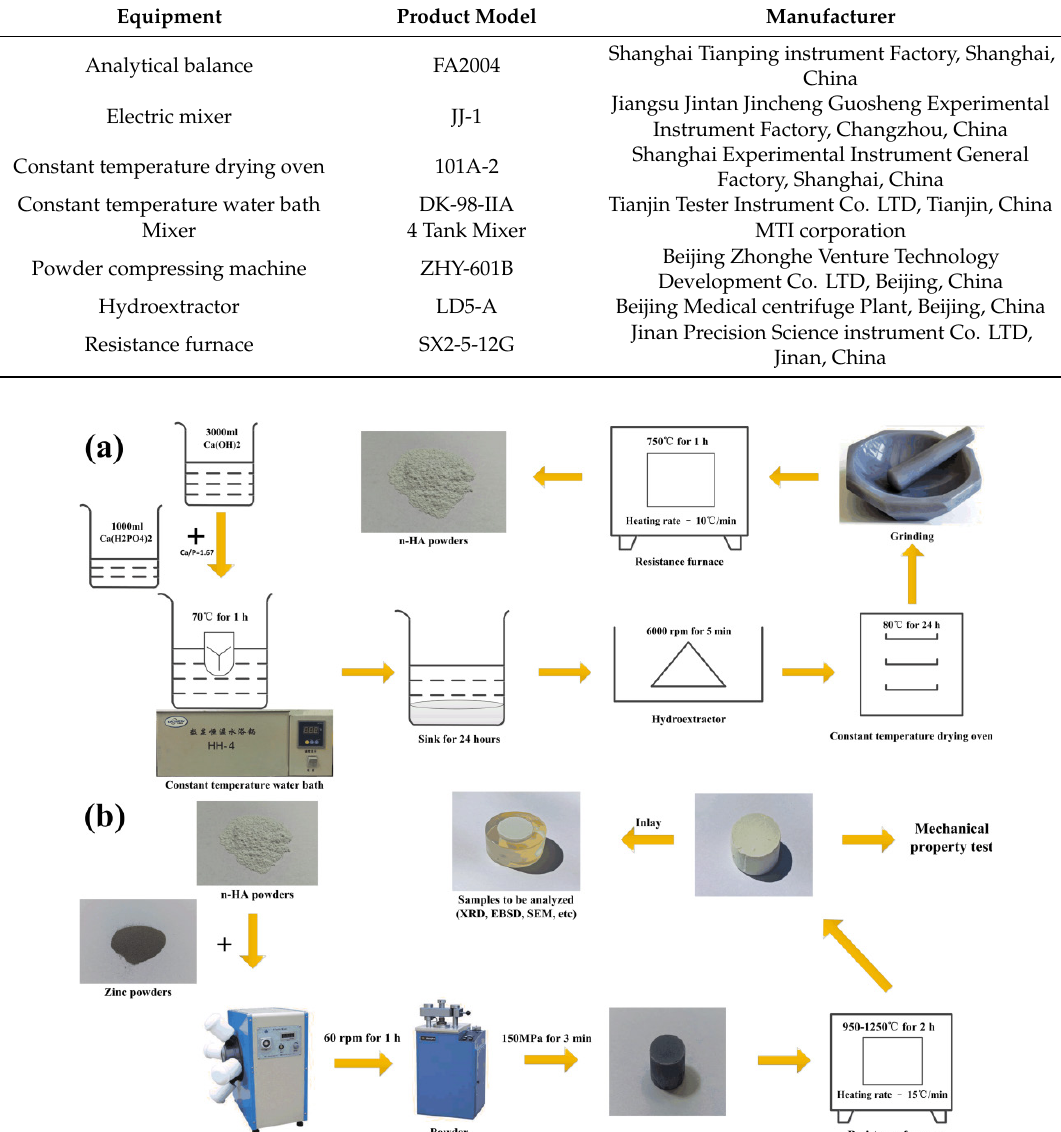
Table 1. Information of experimental equipment for the preparation.